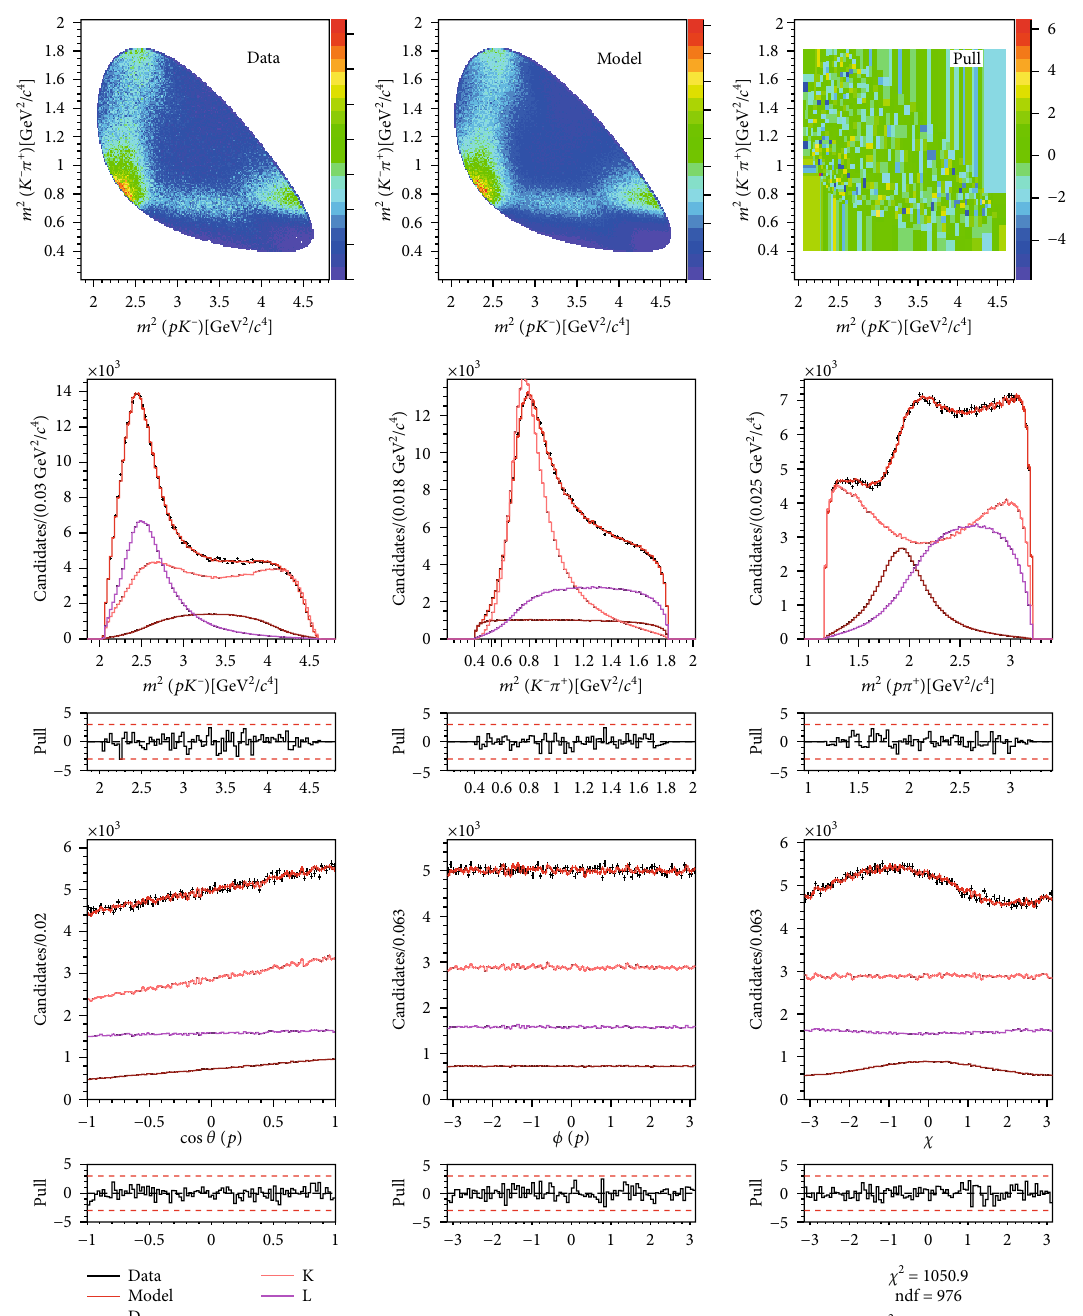
Figure 1: Comparison between Monte Carlo pseudodata ( “ Data ” ) and fi tted toy amplitude model ( “ Model ” ) projections for nonzero polarisation ( P = 0 : 5 ), summarized in Table z